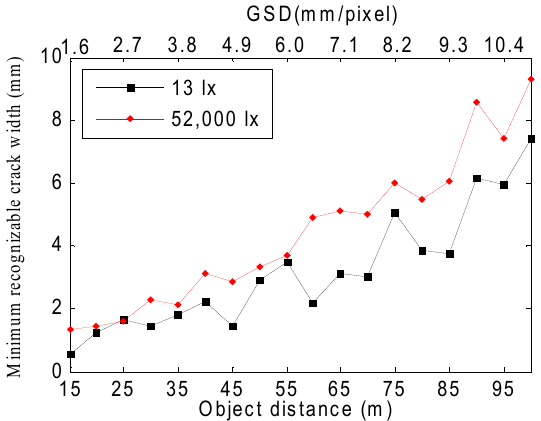
Figure 14. A graph illustrated by calculating the minimum crack width that can be recognized according to the image acquisition distance by assuming MTF10 of the MTF curve as the minimum recognizable crack width.